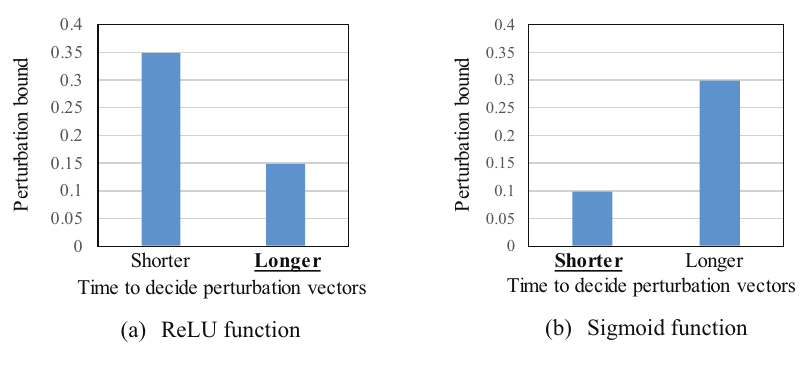
Figure 13: Comparison of results between ReLU and sigmoid functions in proposed attack against MLP model. Perturbation bound are shown in the results. Attack depends on type of activation function: ReLU has longer processing time than sigmoid function. Proposed